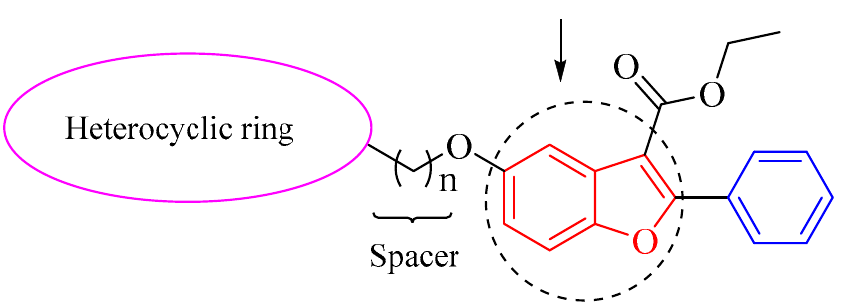
Figure 3. Design strategy for novel hybrid compounds with benzofuran-heterocyclic backbone.